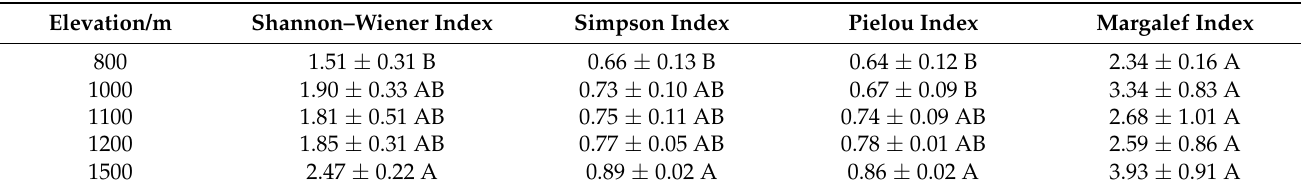
Table 2. Diversity index of the plant community at different elevation gradients.